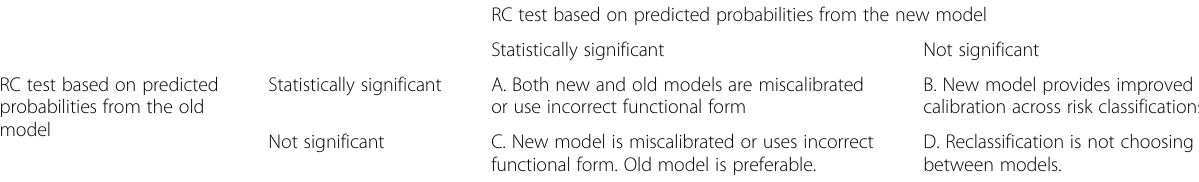
Table 2 The implications of RC testing